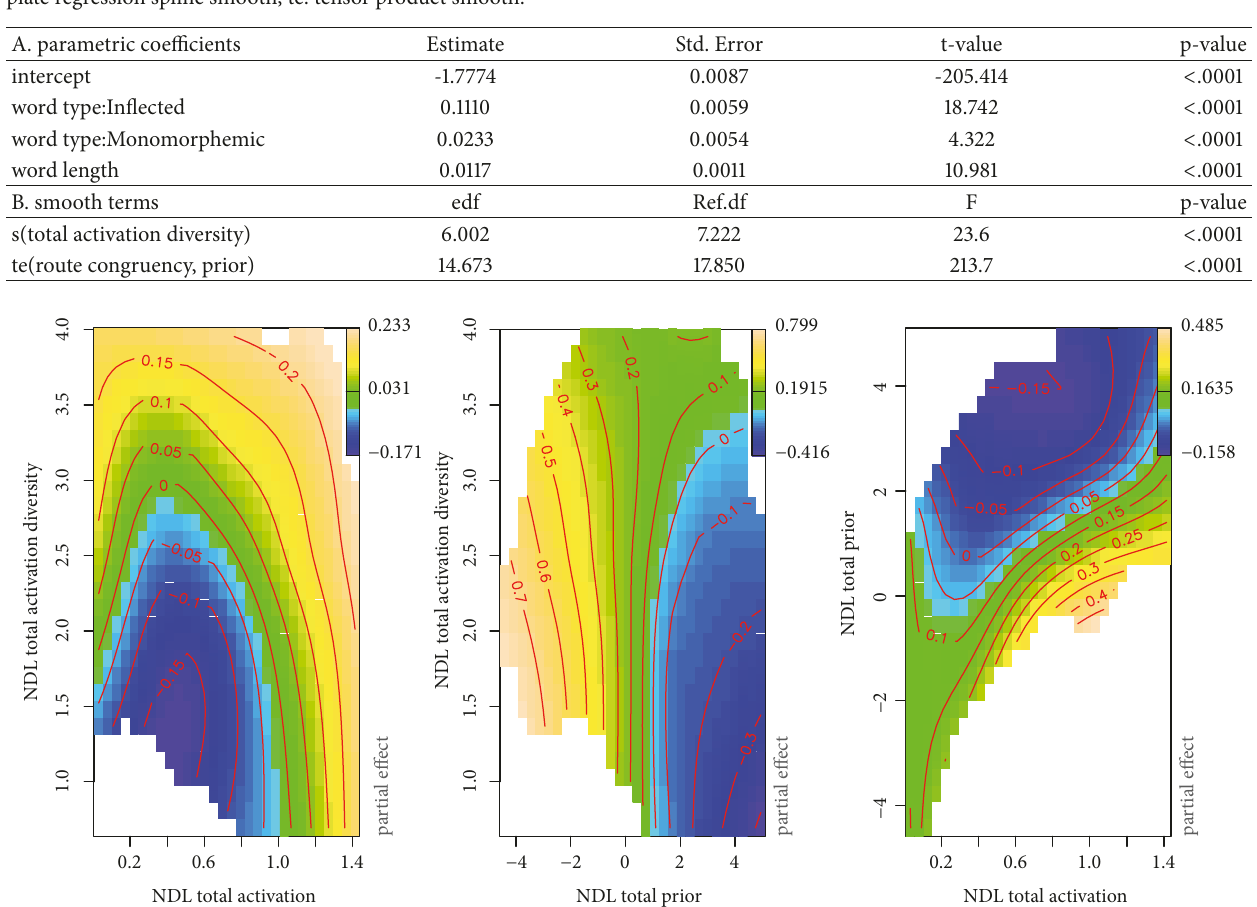
Figure 5: The partial effects of total activation diversity (left) and the interaction of route congruency and prior (right) on RT in the British Lexicon Project. Table 5: Summary of a generalized additive model fitted to response latencies in visual lexical decision using measures based on ldl. s: thin plate regression spline smooth; te: tensor product smooth.